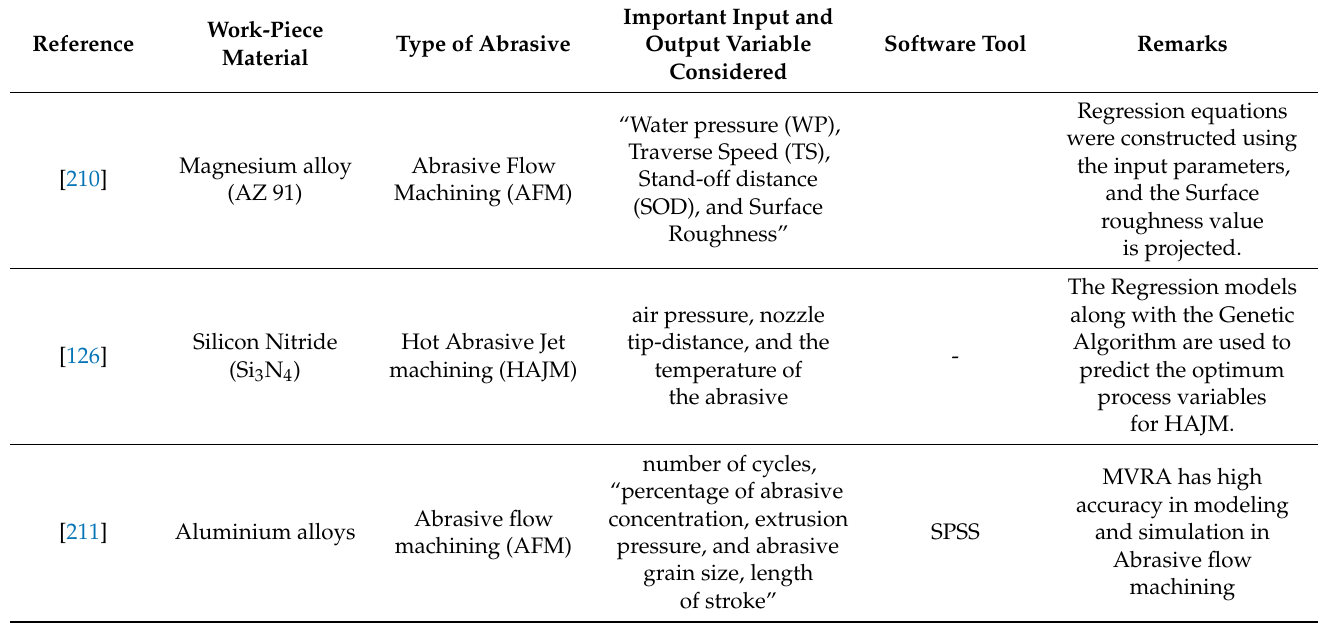
Table 10. Summary table of MVRA-based modeling and simulation of the loose abrasive-based method.